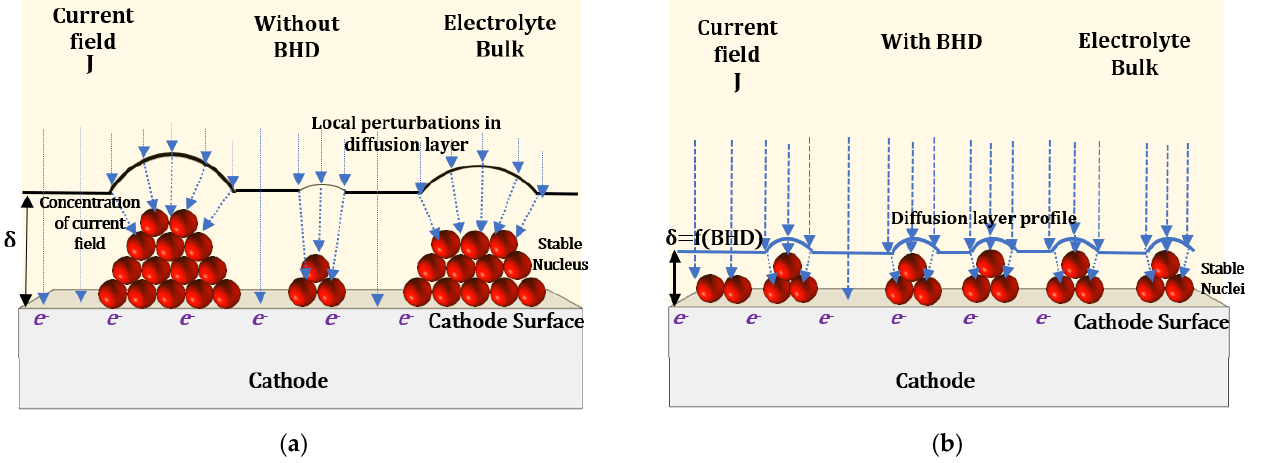
Figure 11. Schematic showing local perturbation in diffusion layer during the nucleation and growth in ECD of eNiCo alloy system; ( a ) without BHD, with its respective diffusion layer profile and concentration of the electric field on the growing nuclei, where a large gradient locally builds up between the larger size nucleus and the smaller size nucleus; and ( b ) with BHD, along with its diffusion layer profile. The dashed blue lines represent the electric field lines and thus the current direction.